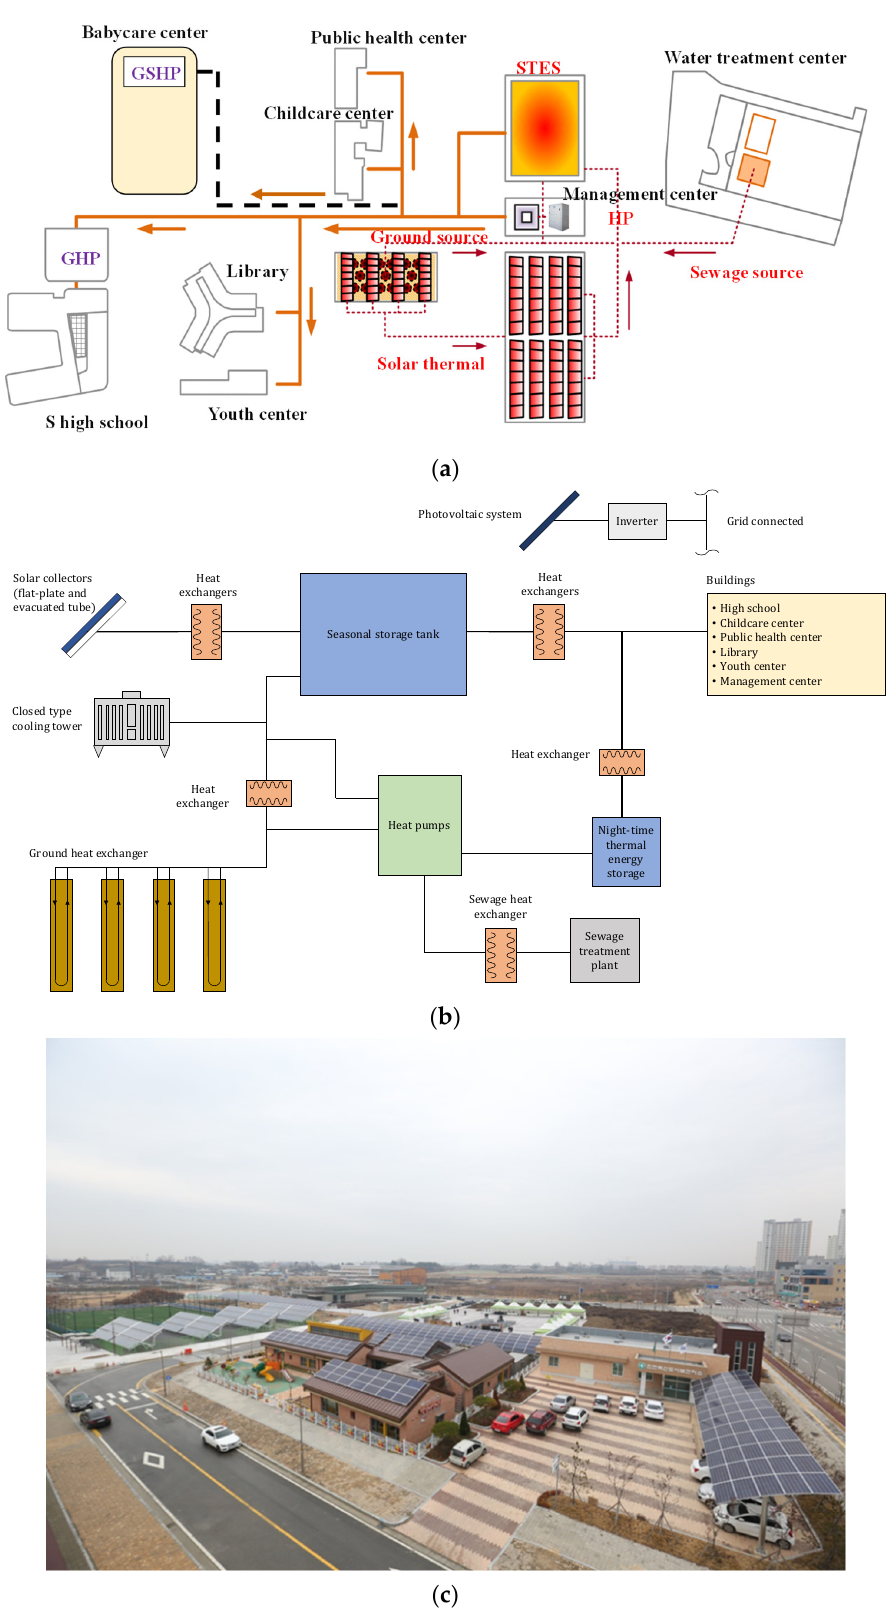
Figure 1. Overview of Jincheon eco-friendly energy town: ( a ) systems and building locations; ( b ) schematic of hybrid renewable energy systems configuration; and ( c ) front view of the